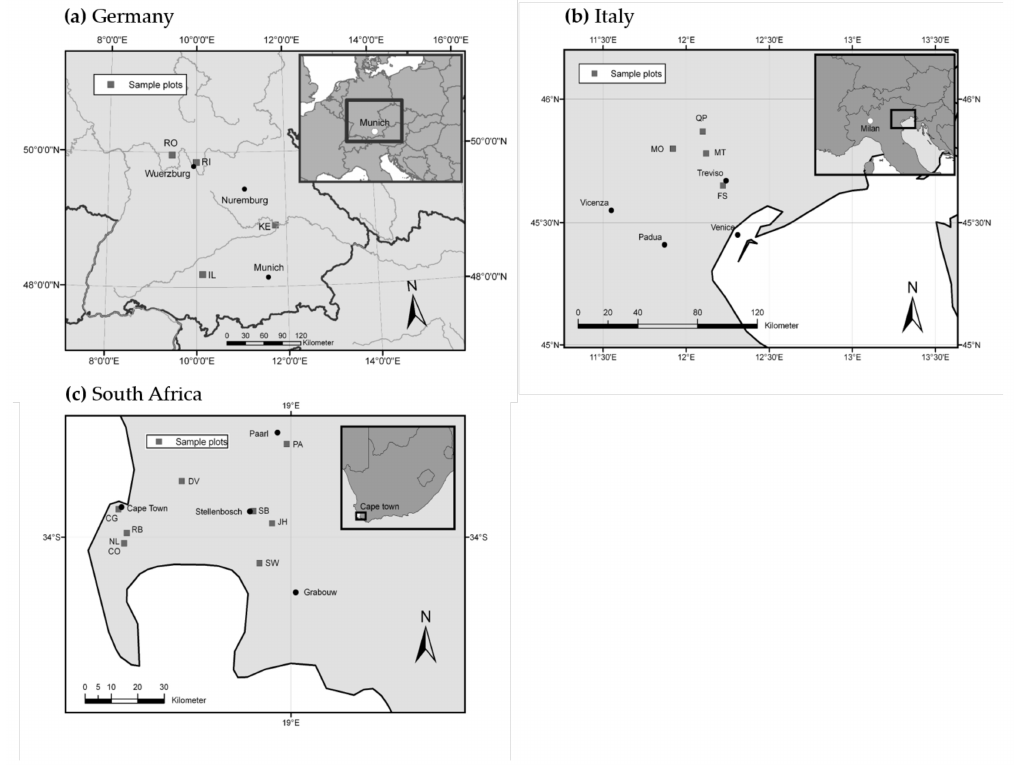
Figure 1. Study and sampling sites: ( a ) Germany, ( b ) Italy, and ( c ) South Africa. Sample plots Germany: Illertissen (IL), Rothenbuch (RO), Rimpar (RI), Kehlheim (KE). Sample plots Italy: Monfumo (MO, Valpago del Montello (MT), Moriago della Battaglia (QP), Piombino Dese (FS). Sample Plots South Africa: Stellenbosch (SB), Jonkershoek (JH), Paarl (PA), Sommerset-West (SW), Durbanville (DV), Oranjezicht (CG), Rondebosch (RB), Newlands (NL), Constantia (CO).